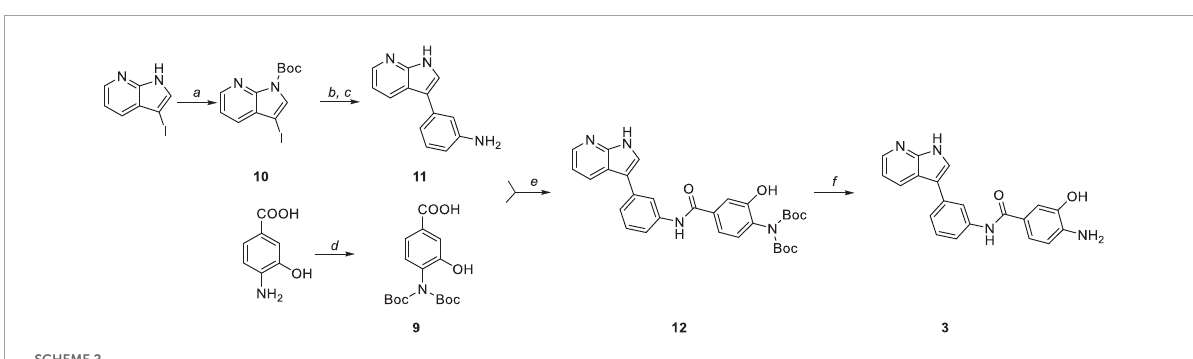
SCHEME2 Synthetic route to compound 3 . Reagents and conditions: (a) (Boc) 2 O, DMAP, DCM, 0 ◦ C to RT, (b) Pd(PPh 3 ) 4 , TEA, HBpin, 1,4-dioxane, 80 ◦ C, (c) 3-Iodoaniline,